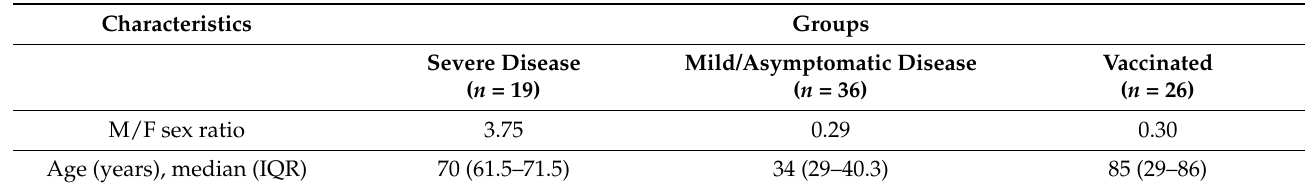
Table 1. Characteristics of the subjects studied, by